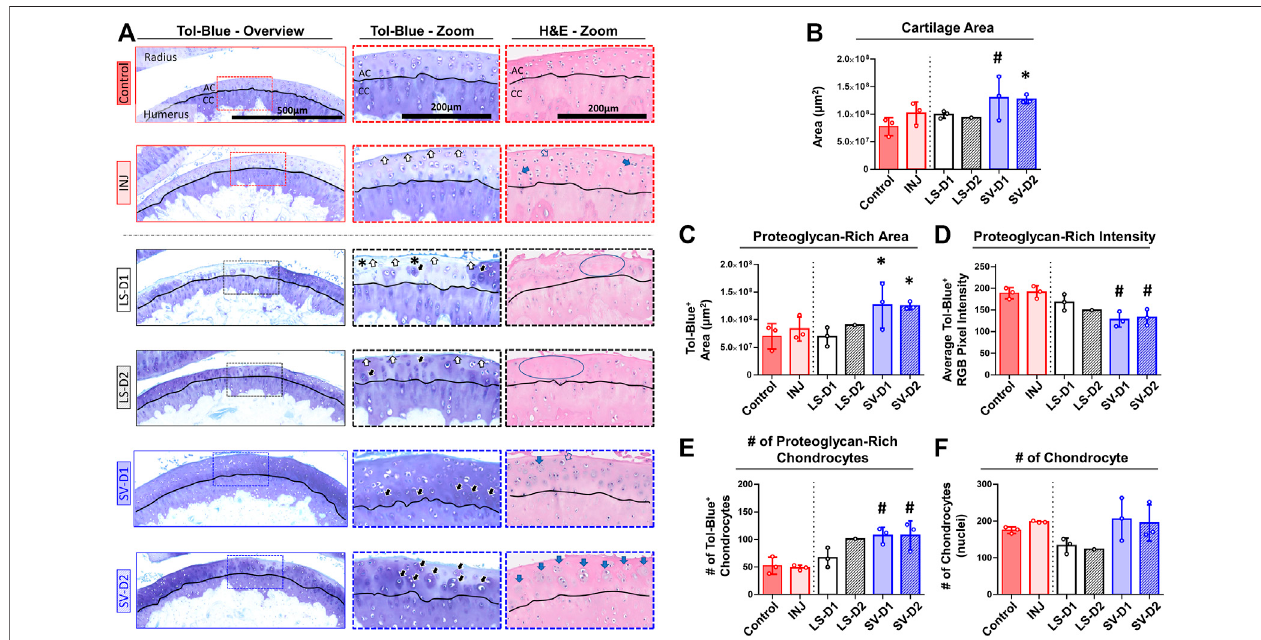
FIGURE 5 | SV, but not LS, reduced cartilage surface irregularities and enhanced proteoglycan content anteriorly. (A) Qualitative histopathology assessment on toluidine blue (Tol-Blue) and hematoxylin and eosin (H&E) midsagittal sections of anterior humerus articular cartilage (AC) and calci fi ed cartilage (CC) demonstrate minor cartilage surface-level fi brillations (white- fi lled arrow) with injury alone (INJ) compared to Control. Treatment with either LS strategy caused worse visible structural and modest proteoglycan loss (asterisks) changes. In contrast, both SV treatments appeared to reduce the severity of this damage and increased cartilage thickness, proteoglycan content, and proteoglycan-rich chondrocytes (black- fi lled arrow), as seen in Tol-Blue images. Note the minor loss of chondrocytes (blue circle) and the drastic change in chondrocyte morphology with an enlargement (open arrow) and cloning/clustering (blue- fi lled arrow) of chondrocytes in the articular cartilage, as seen in H&E images. (B – F) Quantitative cartilage histomorphometry of the humerus articular cartilage at the tissue level largely con fi rms these qualitative assessments while providingadditionalinsightintocellularlevelchangesinthenumberofchondrocytesandthosewithenrichedpericellularproteoglycan.Resultsareshownasmean ± SD; # indicates p ≤ 0.05 signi fi cant difference and * indicates 0.05 < p ≤ 0.10 trending signi fi cance from Control (one-way ANOVA with Dunnett ’ s post-hoc). Note: Control (cid:1) uninjured,age-matched;INJ (cid:1) injurynodrug;LS-D1 (cid:1) losartandosingstrategy1;LS-D2 (cid:1) losartandosingstrategy2;SV-D1 (cid:1) simvastatindosingstrategy1;andSV-D2 (cid:1) simvastatin dosing strategy 2.